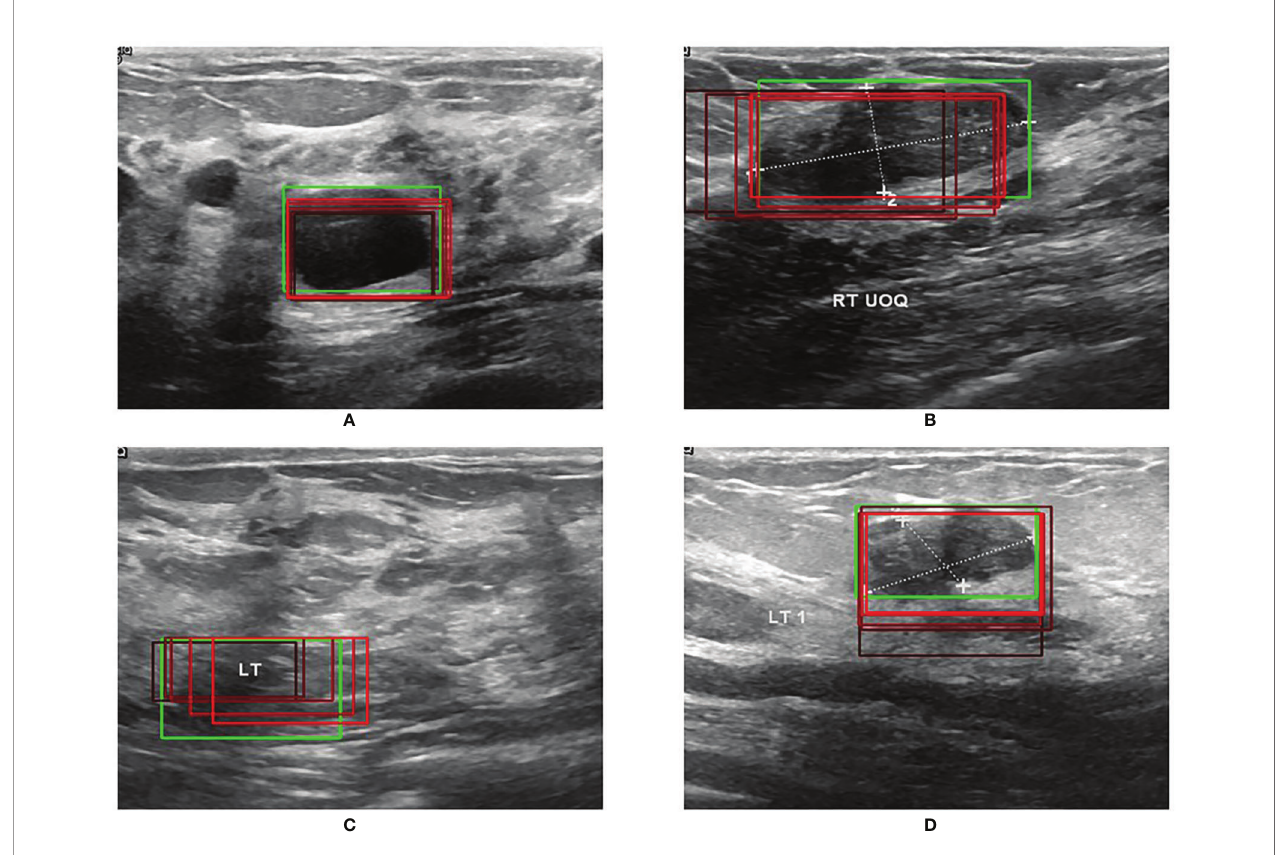
FIGURE 6 | (A – D) Four examples of bounding-box regression iterations.